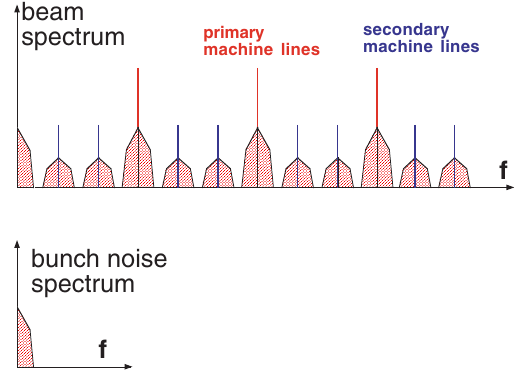
FIG. 2. (Color) Sketch of primary bunch-noise spectrum (bot- tom) and the beam spectrum as seen by the HOMs (top) for beam pulses with pulse